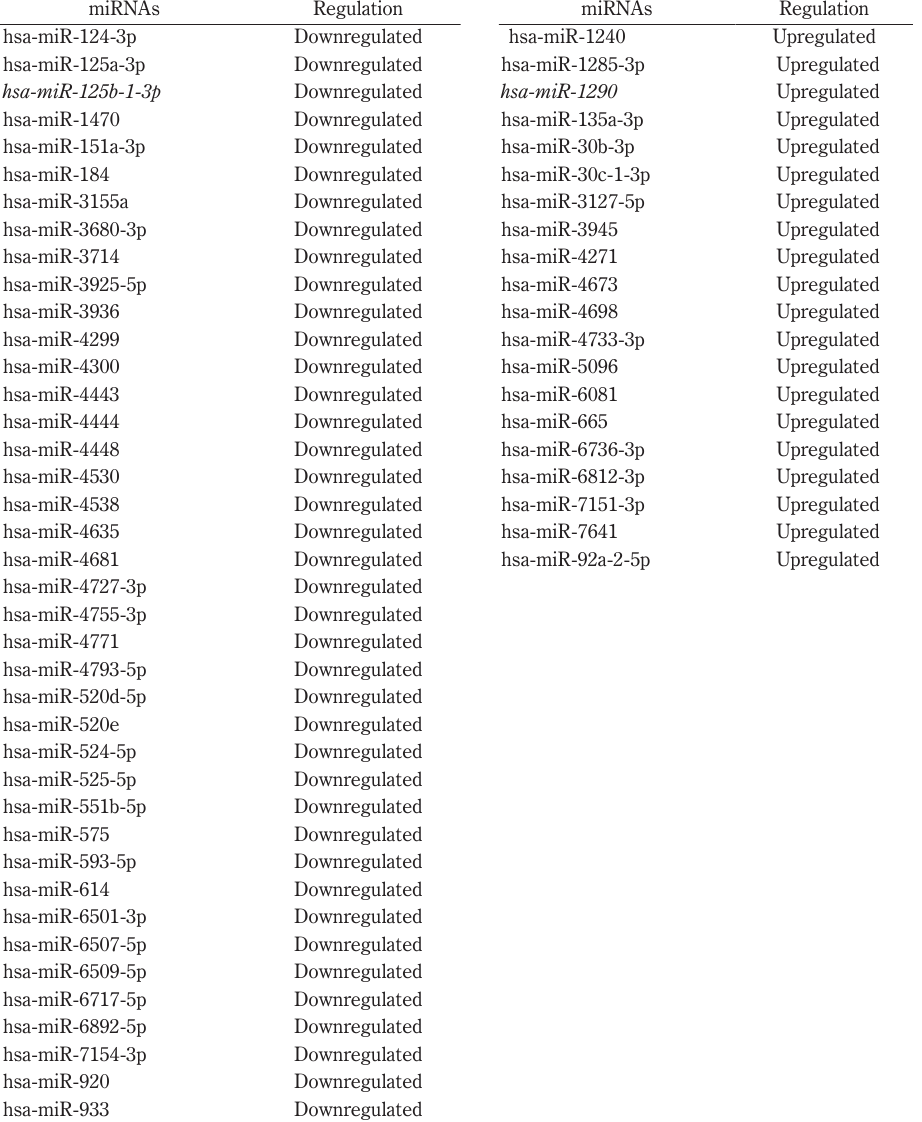
Table 3 Circulating miRNAs that showed significantly different expression levels in patients with heart failure before cardiac rehabilitation compared with